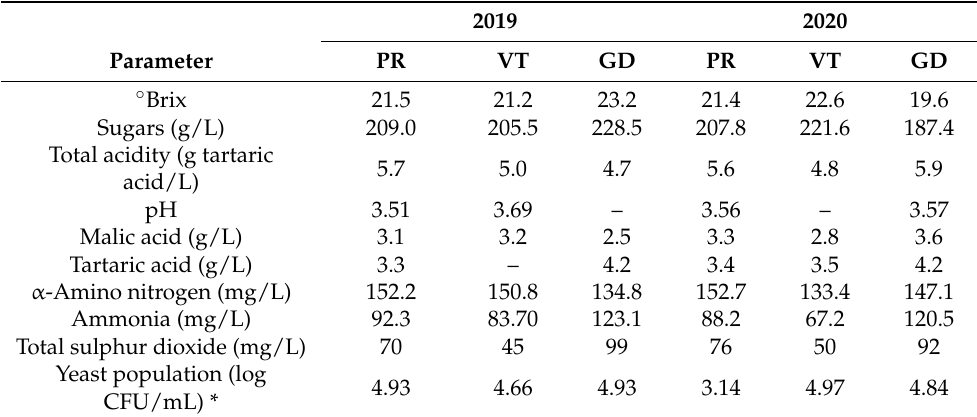
Table 2. Characteristics of Treixadura musts from the different wineries used in this